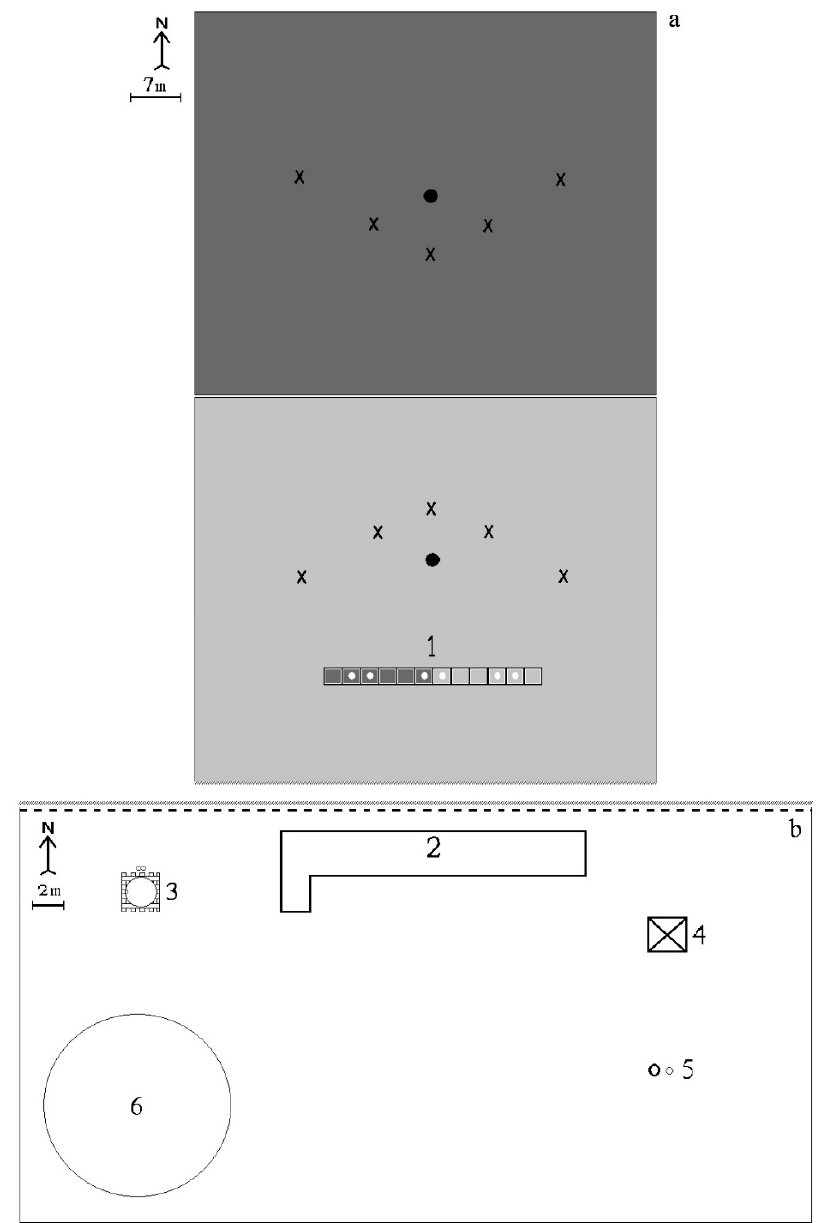
Figure 1. A sketch of the study site at Keszthely Agrometeorological Research Station, where ( a ) and ( b ) denote the experimental field and observation garden, respectively. Three water treatments and measuring towers ( ● ) were placed, as shown in a , as follows: X, rainfed plots; 1, 1–12 evapotranspirometer pots in the field. The evapotranspirometers’ pots with different water and variety treatments are highlighted as follows: ■ , pots of a traditional evapotranspirometer with Sinara ( Sin WW ); ◘ , pots of water-stressed treatment with Sinara ( Sin RO ); ■ , pots of a traditional evapotranspirometer with unlimited water in Sigalia ( Sig WW ); ◘ , pots of water-stressed treatment with Sigalia ( Sig RO ). In (b) the following abbreviations were used: 2, measuring cellar; 3, US class “A” pan; 4, wind tower with a pyranometer; 5, QLC-50 automatic climate station; 6, evaporation pan with a surface area of 20 m 2 . The same experimental setup was used in both observation seasons (2017 and 2018). Several plant indicators (phenology, leaf and leaflet areas, chlorophyll index, yield, water use efficiency) were measured in all water and variety treatments (upper part (a): 1 and X). Daily evapotranspiration was measured in (a) 1, 1–12 evapotranspirometer pots. The crop coefficient was derived from these equipment pots. Evapotranspiration totals were also estimated from the field (a). All meteorological variables were derived from observational garden (b).